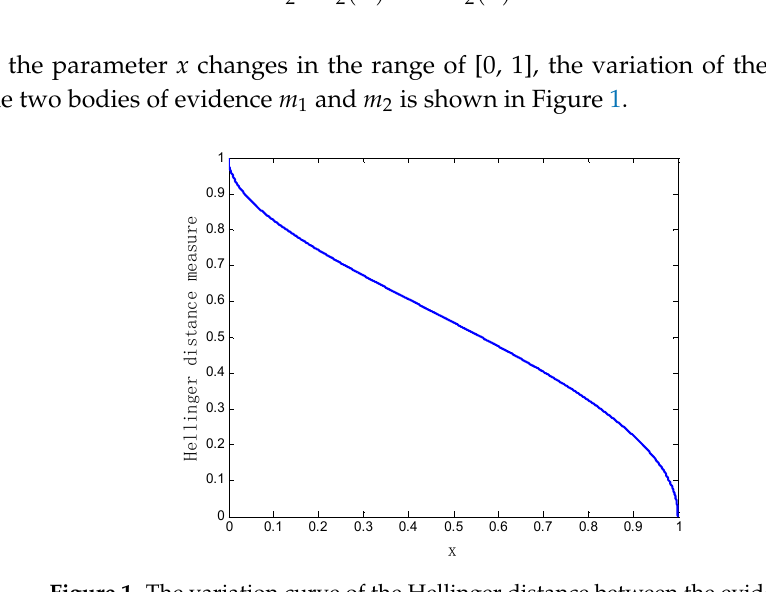
Figure 1. The variation curve of the Hellinger distance between the evidence.